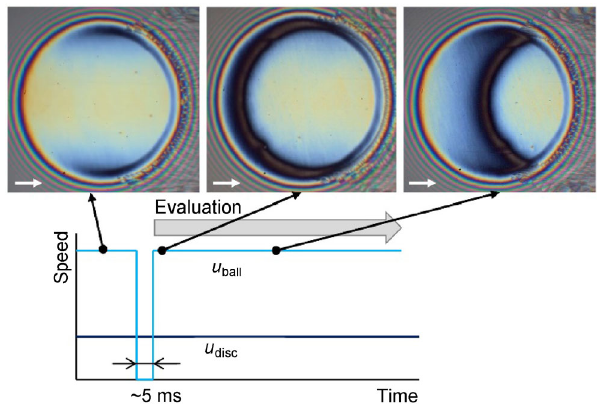
Fig. 6 Scheme of contact surfaces speeds evolution .